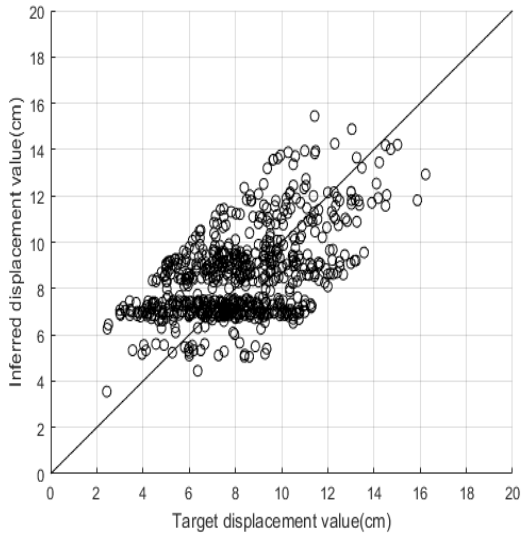
Figure 9. Test results of 4400 training samples for spectral-yield displacement S dy with 20 building characteristics. Table 8. Model accuracy with testing 20 building characteristics for spectral-yield acceleration S ay